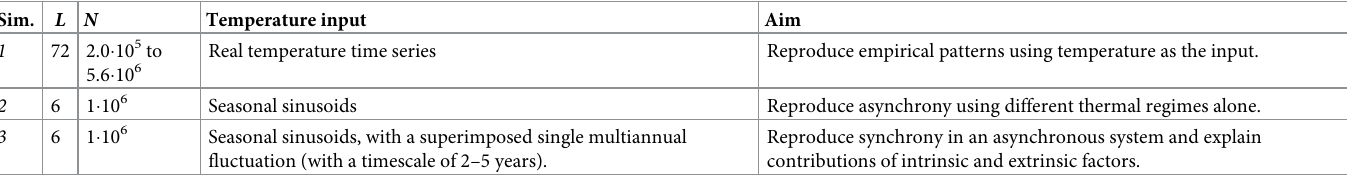
Table 1. Simulations used in this study. We use the mechanistic dengue model, with different temperature inputs, numbers of locations L , and initial population sizes per location N , to address specific but related questions (column Aim). Each location was run as an independent simulation (no host movement between locations), with a total population size corresponding to the population size of each province (simulation 1), or equal across locations (simulations 2 and 3), using the same host birth and death rates, such that the only differences across locations were temperature (all simulations), and population size (simulation 1 only; see section “Further details on simu- lation studies” in S1 Appendix). In all cases, simulations were run assuming mean cross-protections between dengue serotypes of 6 months, 1 year, and 2 years. Outputs had a monthly resolution. Sim. L